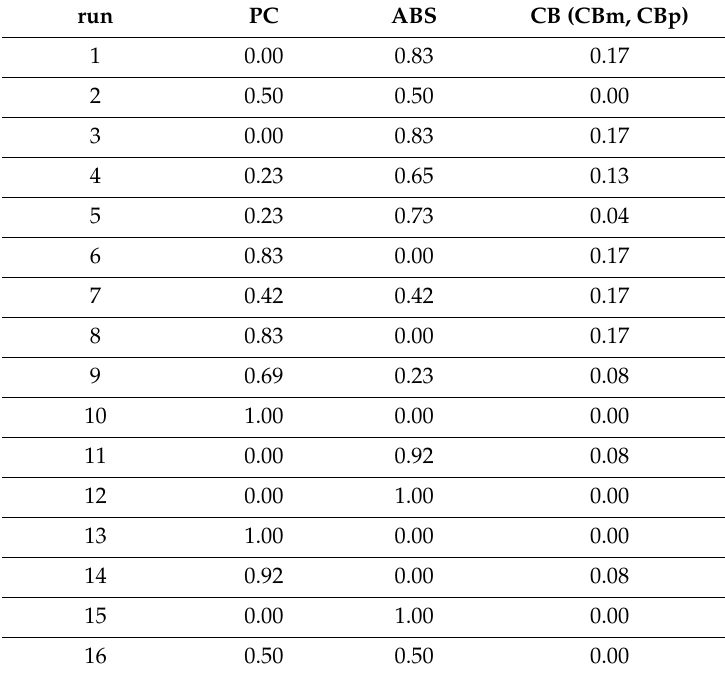
Table 1. Percentage of the composition of polycarbonate (PC) / acrylonitrile–butadiene–styrene (ABS) and carbon black (CB).